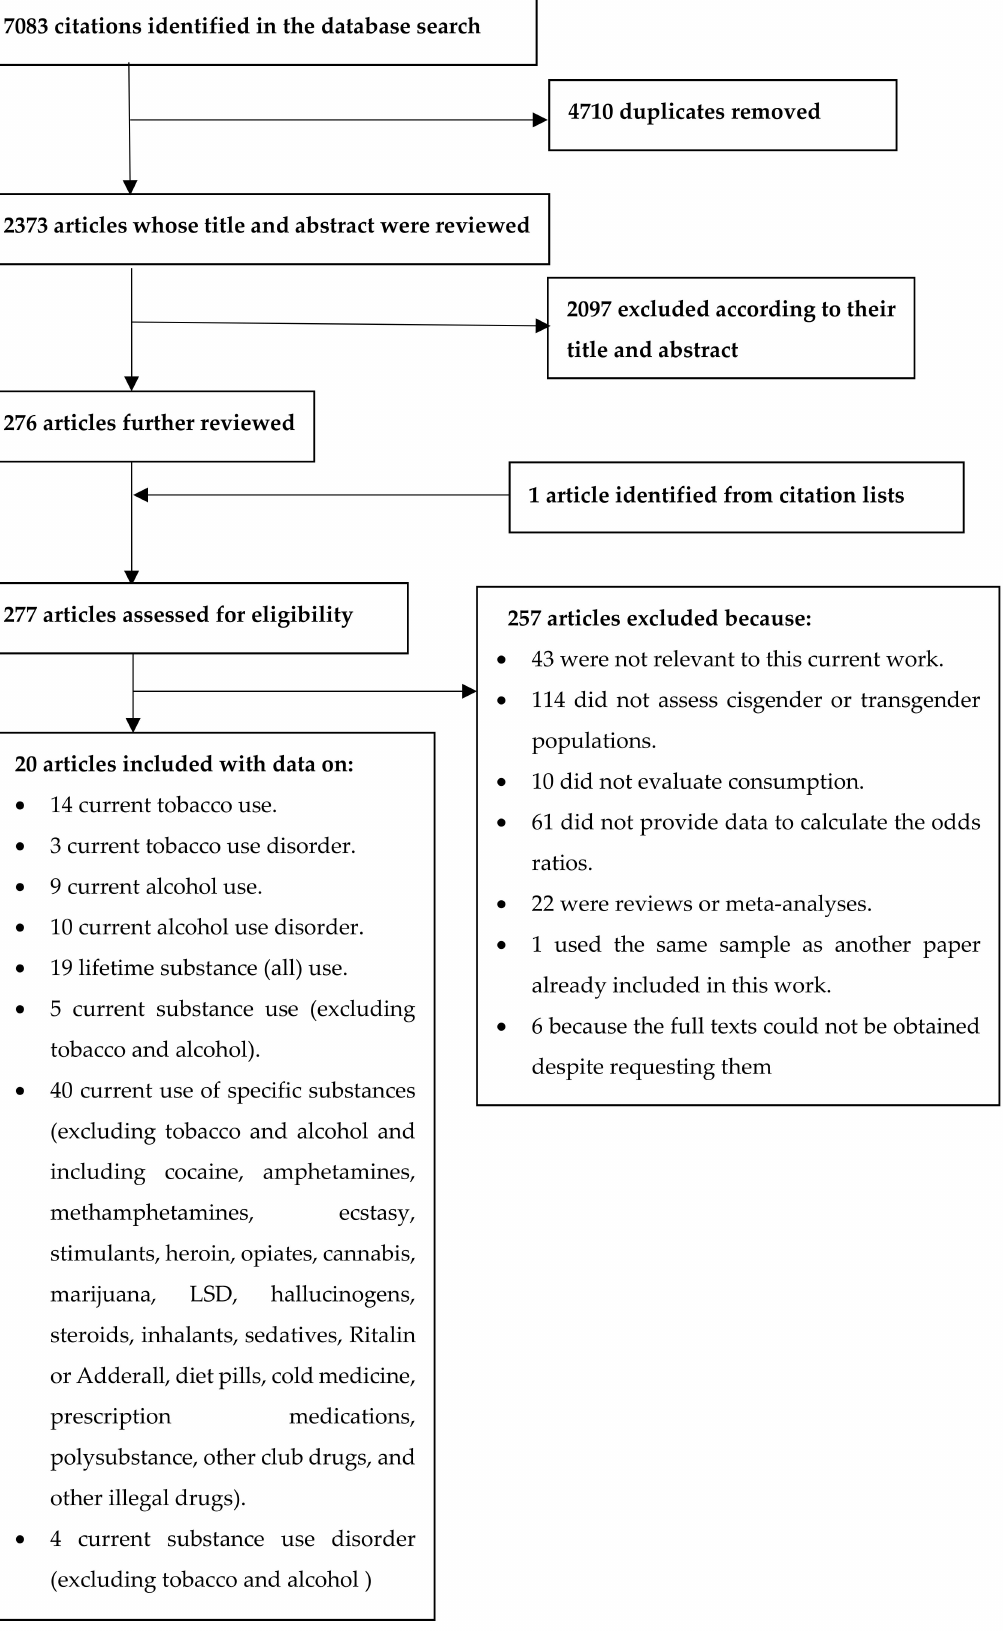
Figure 1. Flowchart of the systematic review process used to select articles for inclusion in this